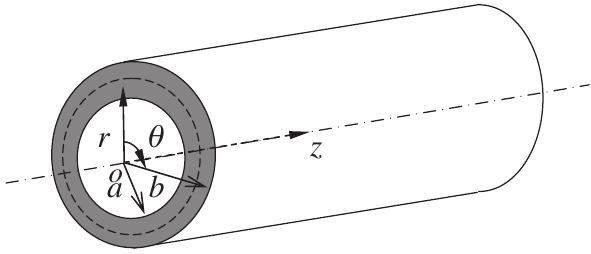
Figure 1 Geometrical configuration of an FGM hollow